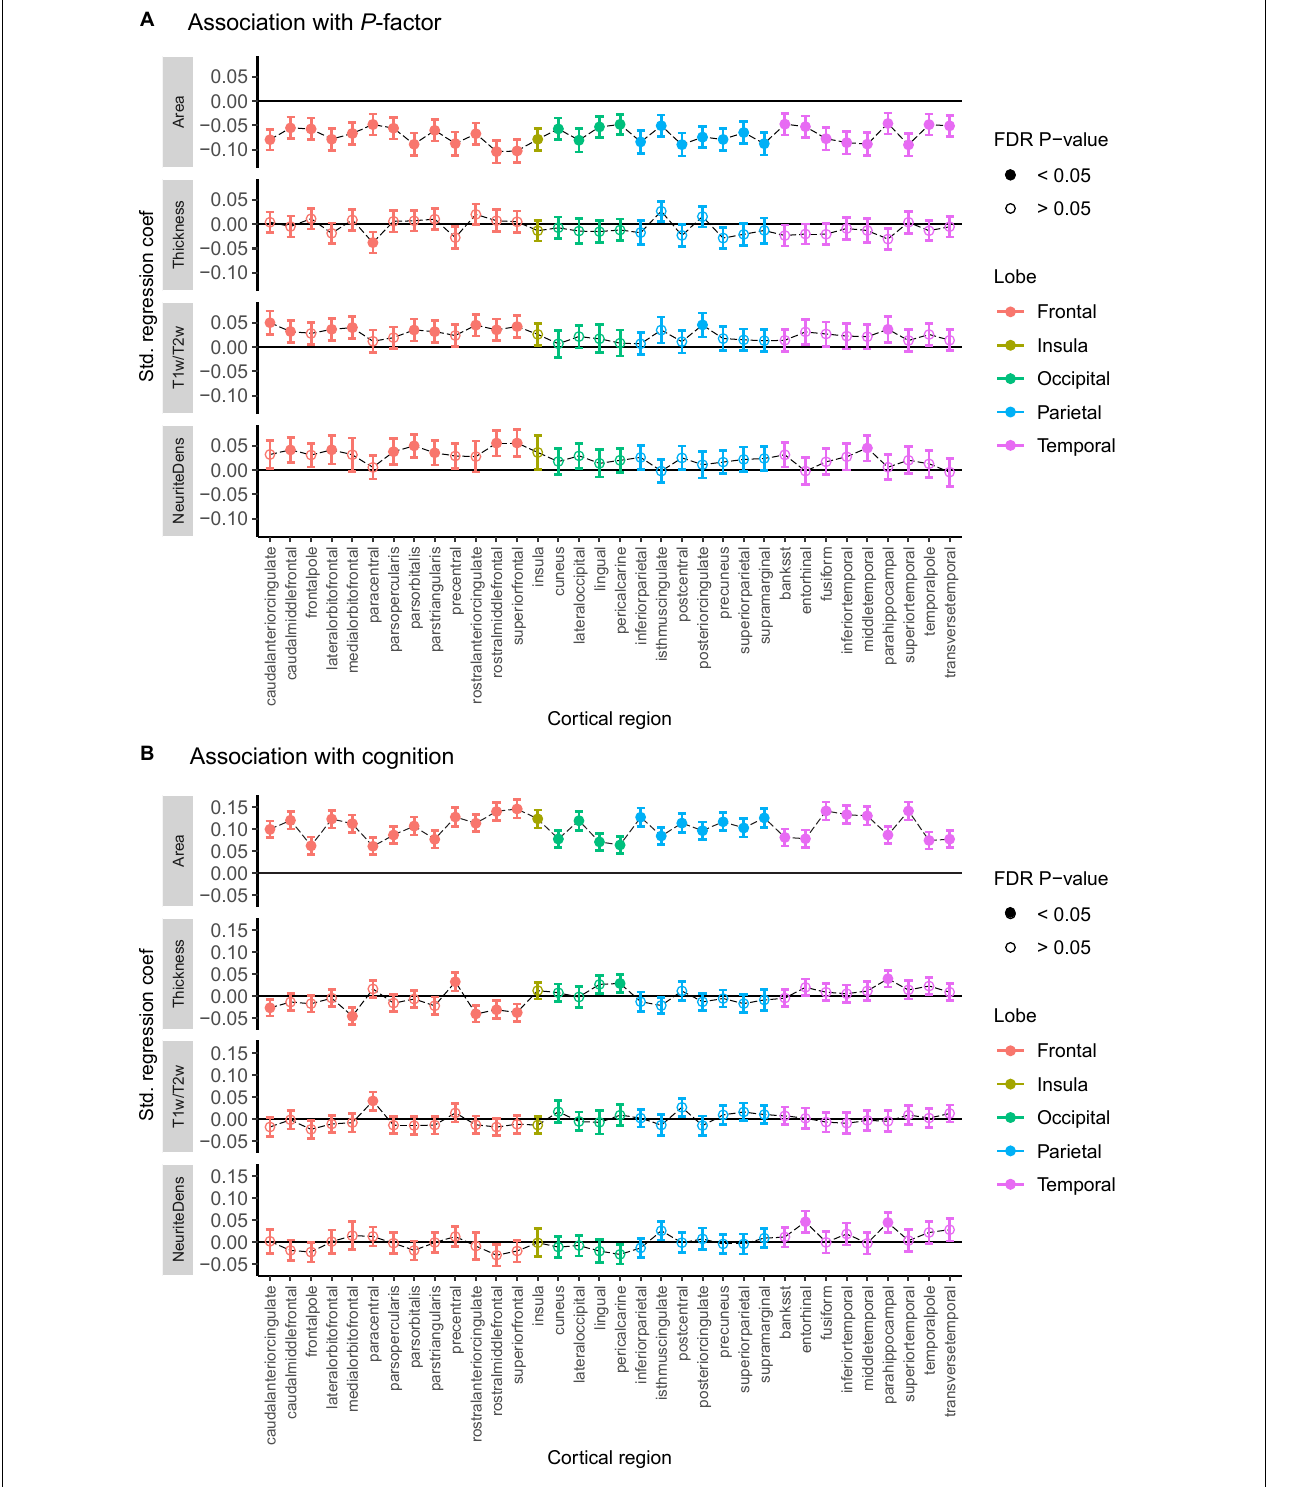
FIGURE 1 | Association between general psychopathology (A) and cognitive score (B) with cortical thickness, the surface area, the T1w/T2w ratio, and neurite density (labeled “NeuriteDens”) across the 34 cortical regions of the Desikan—Killiany atlas. Standardized effect sizes (betas) plotted on the y -axis from linear mixed models adjusting for the effect of age, sex, and scanner effects. Error bars represent 95% confidence intervals for the estimates. Filled-in circles represent FDR-corrected p < 0.05.